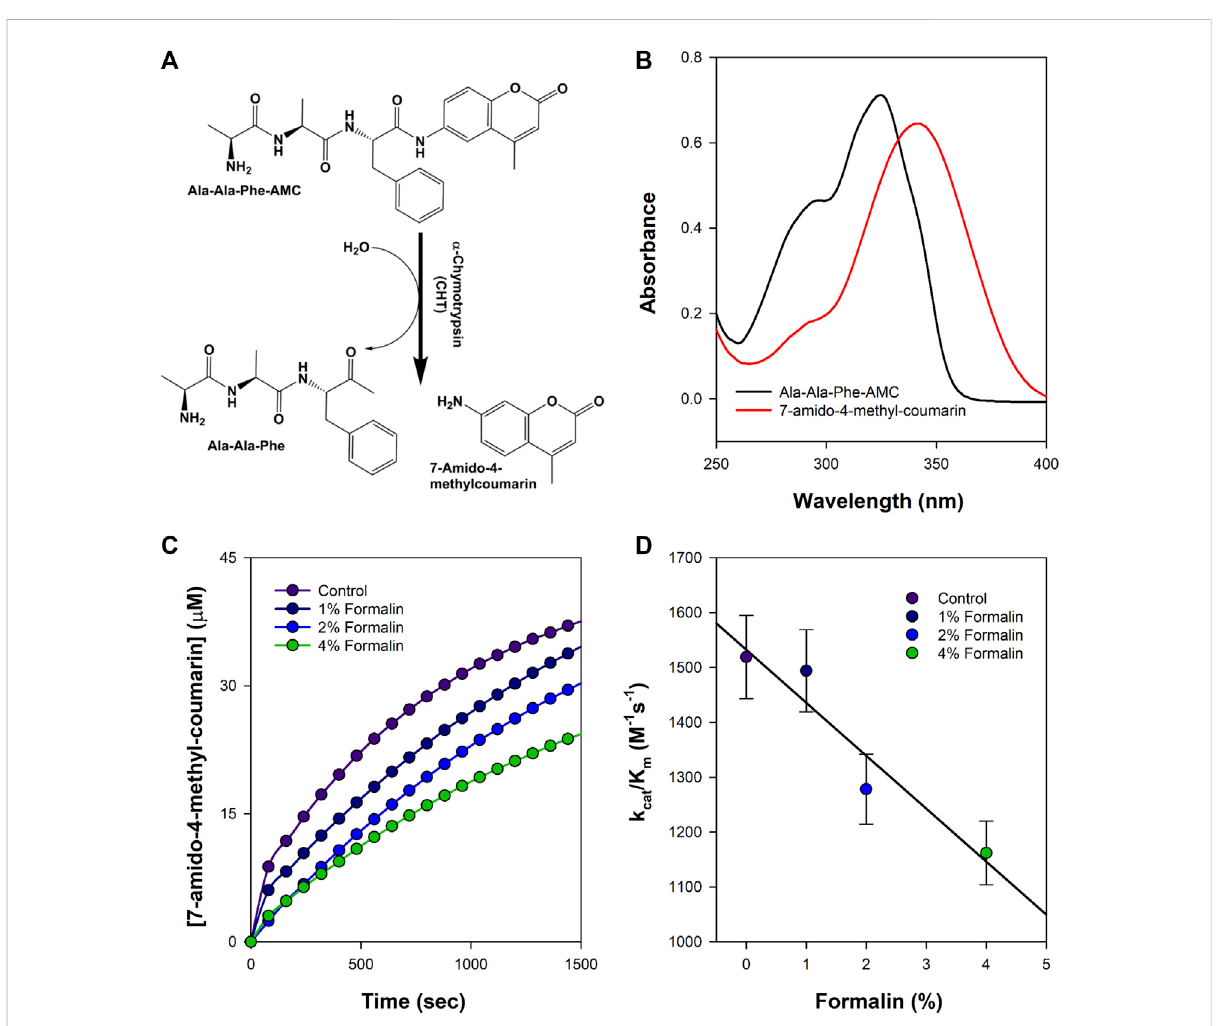
FIGURE 2 Schematicrepresentationoftheformalintreatedenzymecatalysis. (A) SimplereactionoutlinecatalysedbyCHT;thesubstrateAMChydrolysed to produce 7-amido-4-methyl-coumarin. (B) Absorbance spectra of the substrate AMC and product 7-amido-4-methyl-coumarin during catalysis. (C) Product formation at different representative formalin concentration; diminishing product formation with increased formalin concentration. (D) Apparent catalytic ef fi ciency (k cat /K m ) at different representative formalin concentration; retarding catalytic ef fi ciency is consistent with decreasing product formation with increasing formalin concentration (Experiments were performed in